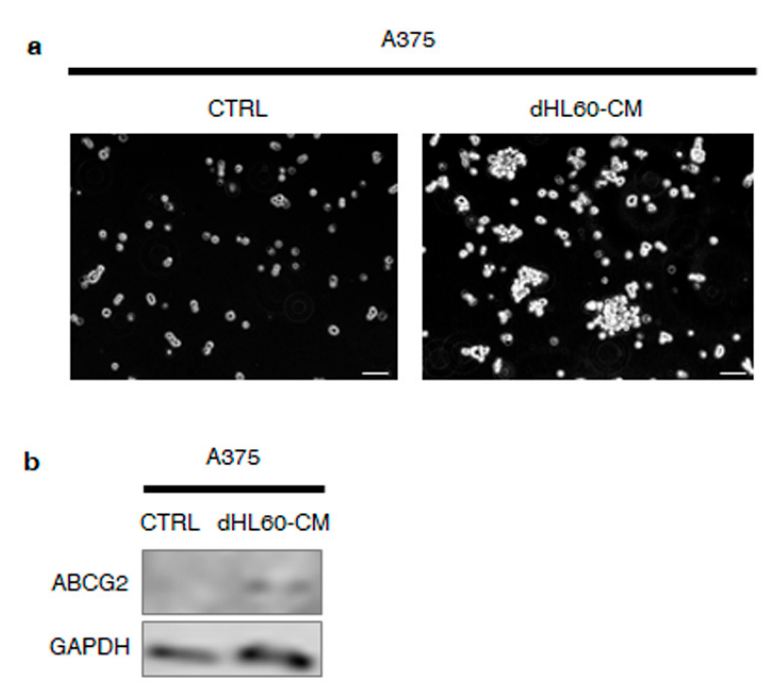
Figure 6. Melanoma SC-incubated neutrophils confer stemness properties to melanoma non-stem cells. ( a ) A375 cells were incubated with dHL60–CM, obtained from dHL60 cells previously exposed to CSC–CM for 24 h. After 7 days, sphere formation assay was performed to determine the spheroidogenic ability of A375 cells. One representative experiment from three independent tests is shown. Scale bars are 30 µ m. ( b ) A375 cells were incubated with dHL60–CM, obtained from dHL60 cells previously exposed to CSC–CM for 24 h. After 7 days, Western blot analysis was carried out to analyze the expression of ABCG2. GAPDH was used as a loading control. One representative experiment from three independent tests is shown.